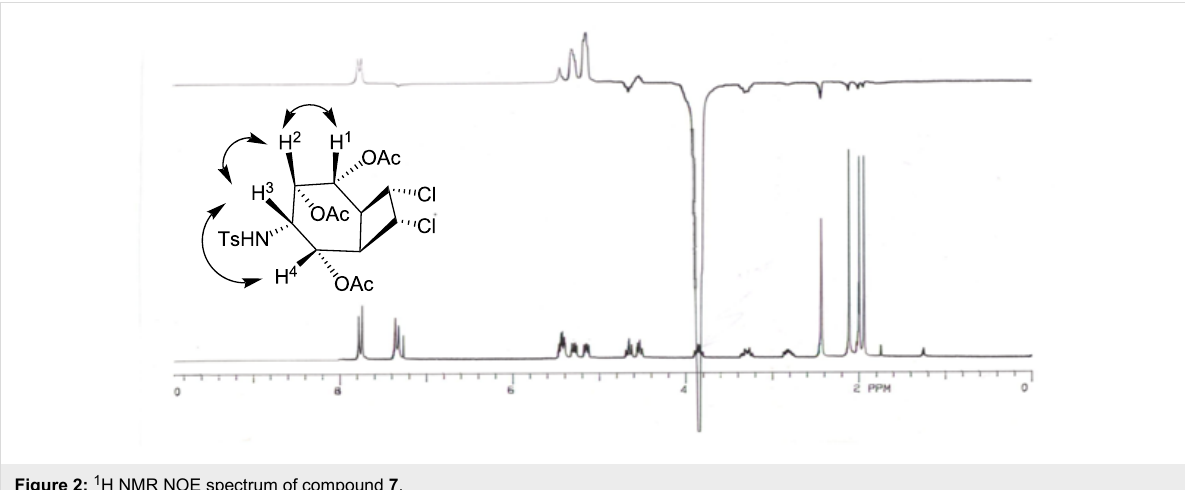
Figure 2: 1 H NMR NOE spectrum of compound 7 .